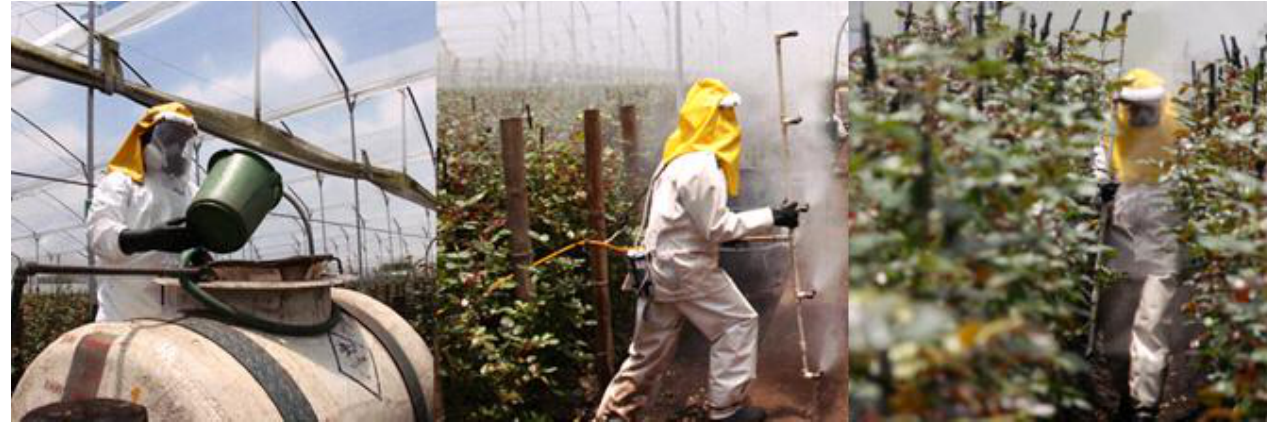
Figure 2. Preparation ( left ) and application of pesticide ( central and right ). in a greenhouse for flower production in